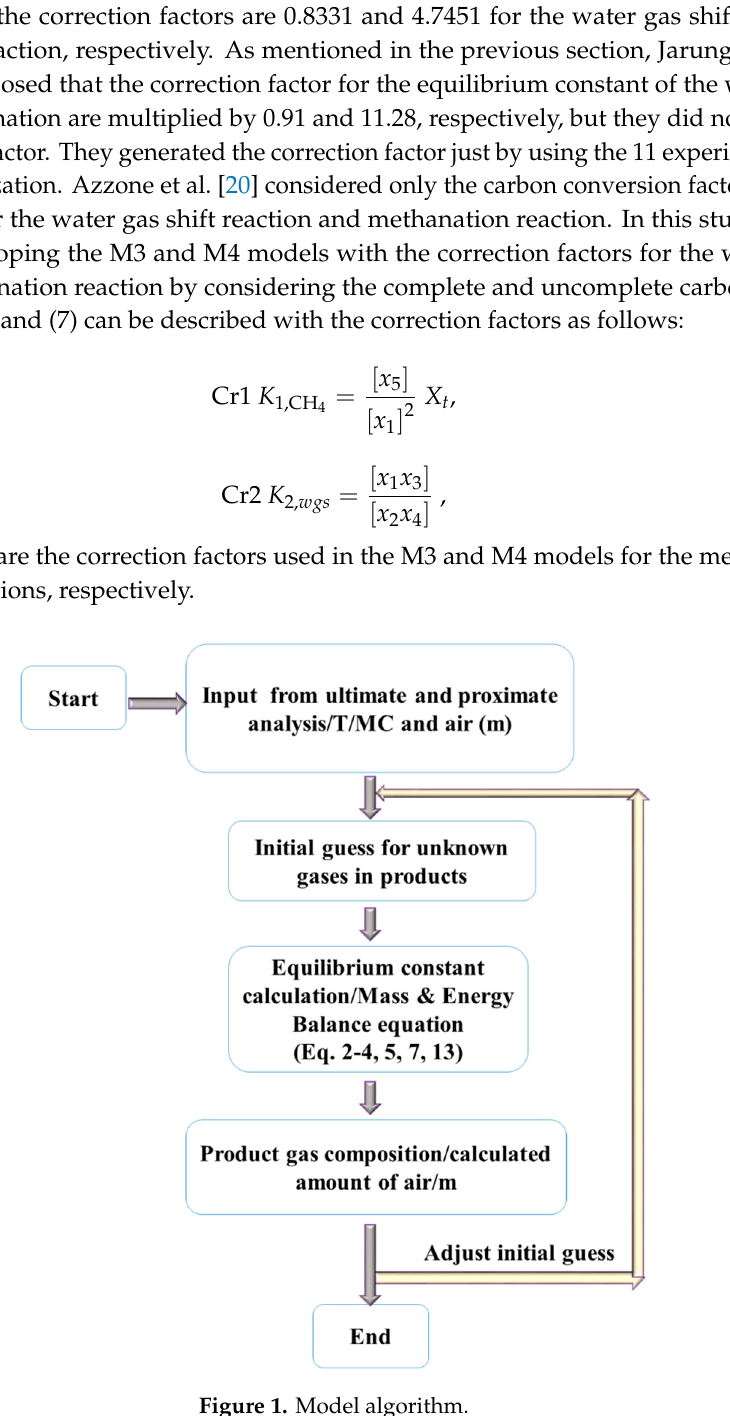
Figure 1. Model Figure 1. Model algorithm. Table 1. Iterative calculation procedure for the models.